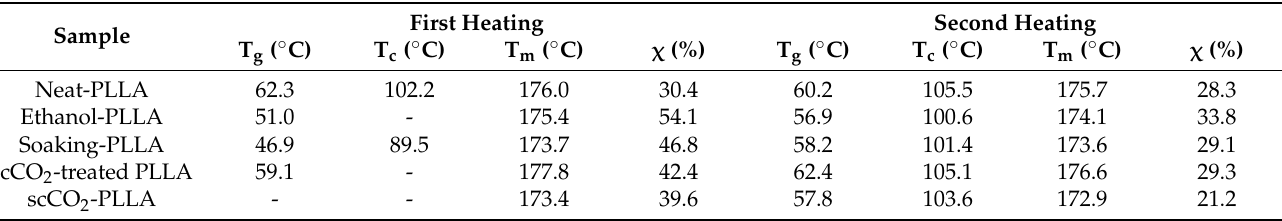
Figure 5. DSC thermograms of neat PLLA, PLLA treated with the impregnation solvent, and PLLA impregnated with aspirin using the soaking method and scCO 2 method, ( a ) first heating and ( b ) second heating. Table 4. Crystallinity and thermal transitions of neat PLLA, PLLA treated with the impregnation solvent, PLLA impregnated with aspirin by soaking method and by scCO 2 method.